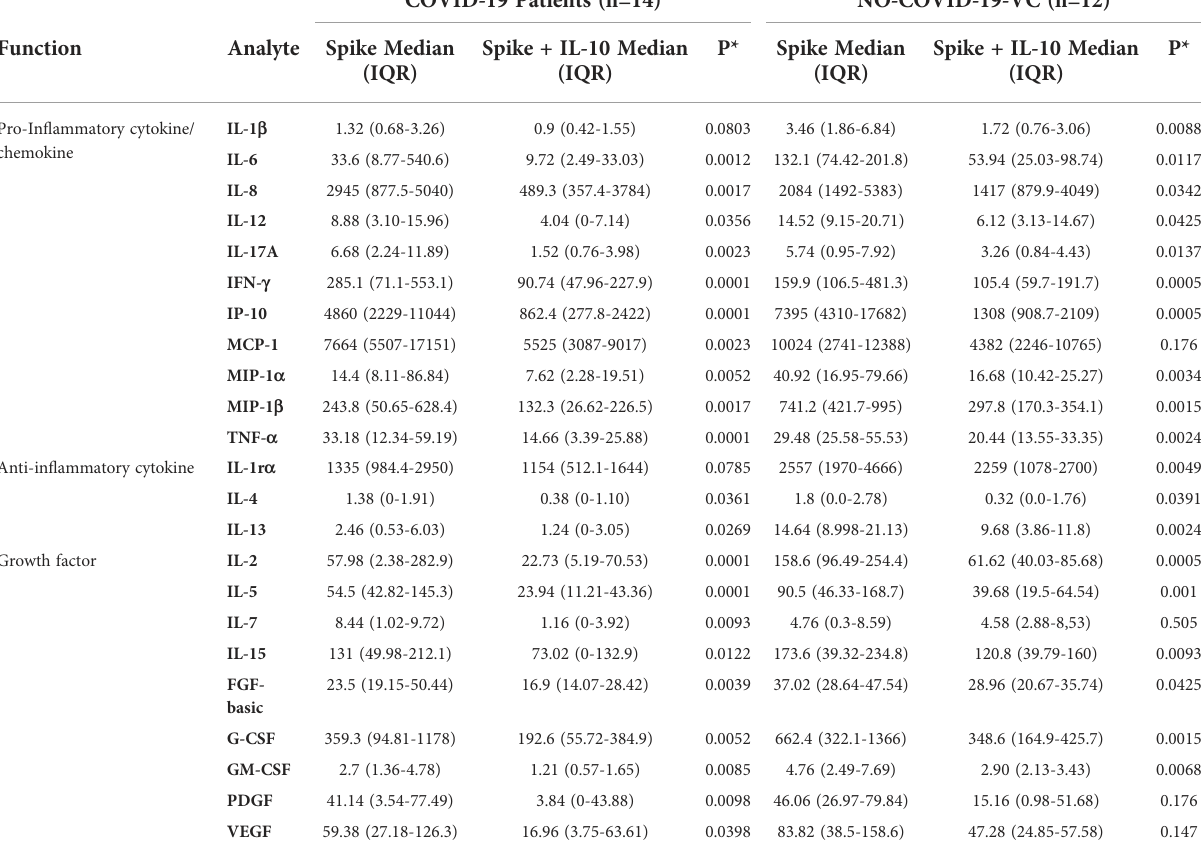
TABLE 4 IL-10 signi fi cantly downregulates several Spike-induced cytokines, chemokines, and growth factors in COVID-19 patients and NO COVID-19-VCs of study population “ B ” , using a 27-plex multiplex assay. COVID-19 Patients (n=14)